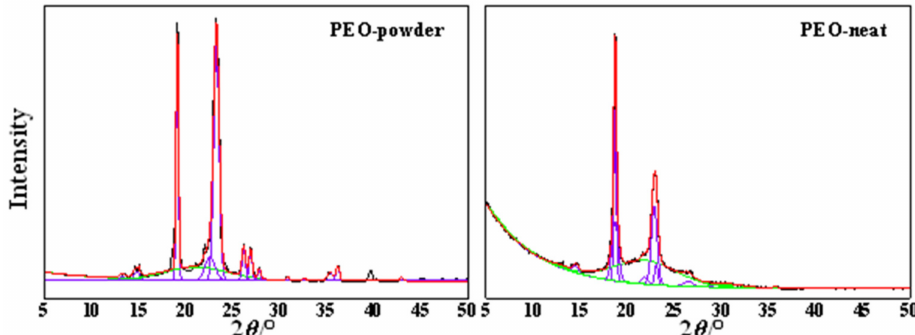
Figure 5. Deconvolution of the XRD patterns of: PEO-powder and electrospun PEO-neat. Violet: crystalline peaks; green: amorphous peaks; red: calculated curve; black: observed curve.